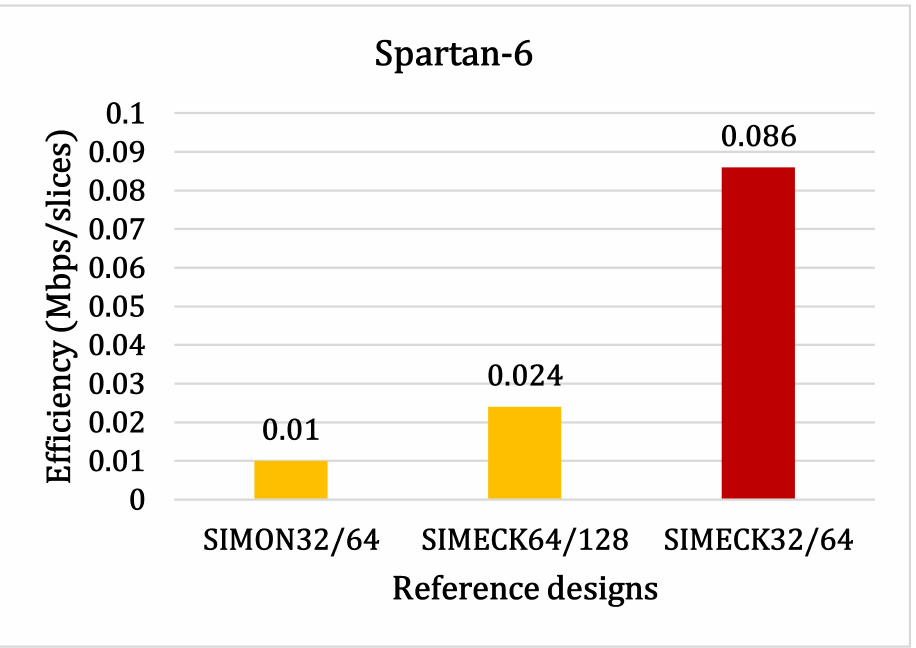
Figure 6. Efficiency evaluation with designs of [15,30] on Spartan-6 FPGA. From left to right, the orange bars with values on top 0.01 and 0.024 are for [15] and [30], respectively. Similarly, a red color bar shows our